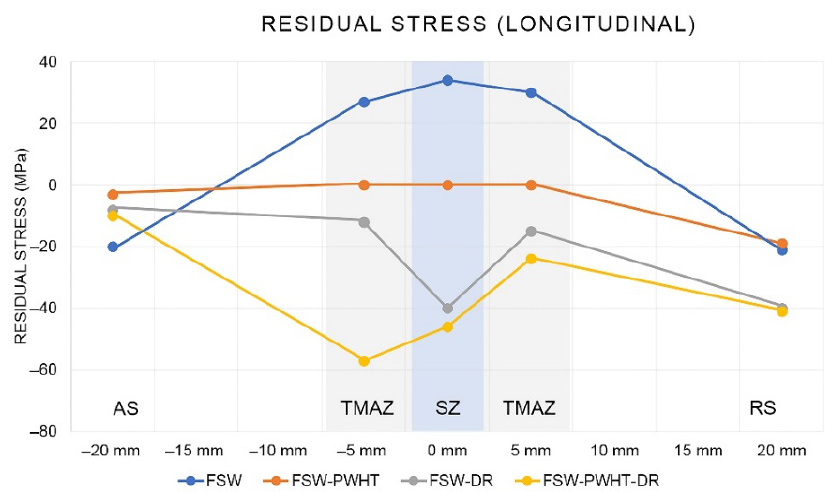
Figure 18. Residual stress in the transverse direction.